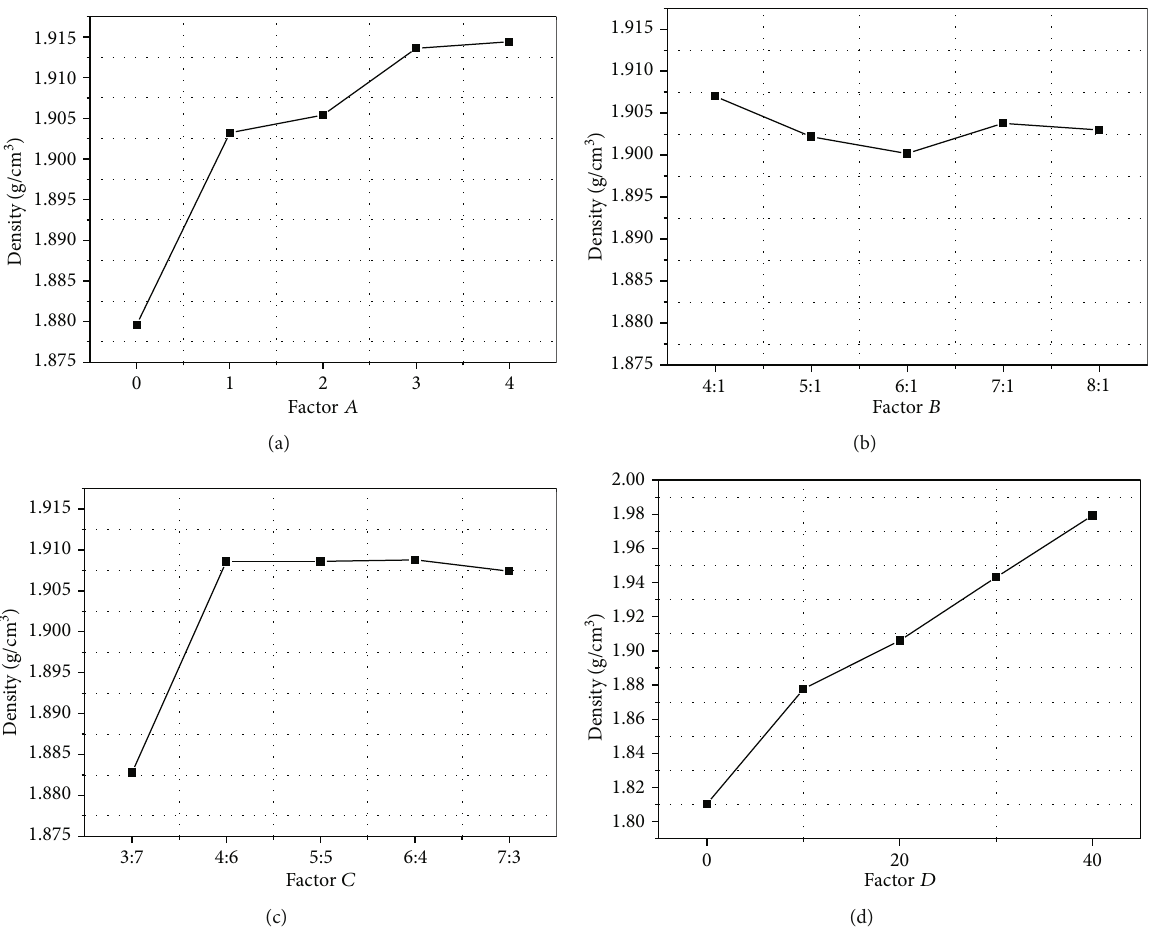
Figure 4: Intuitive analysis chart of density in fl uencing factors: (a) factor A , (b) factor B , (c) factor C , and (d) factor D .